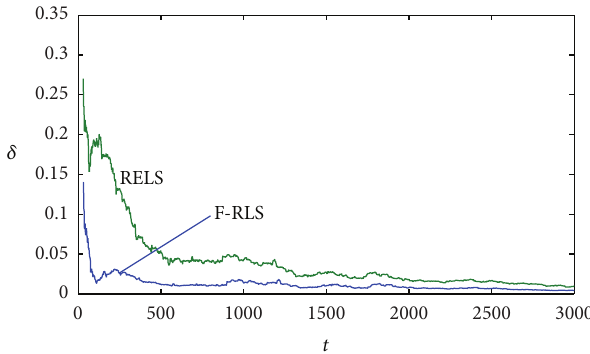
Figure 2: The estimation errors 𝛿 versus 𝑡 ( 𝜎 2 = 0.10 2